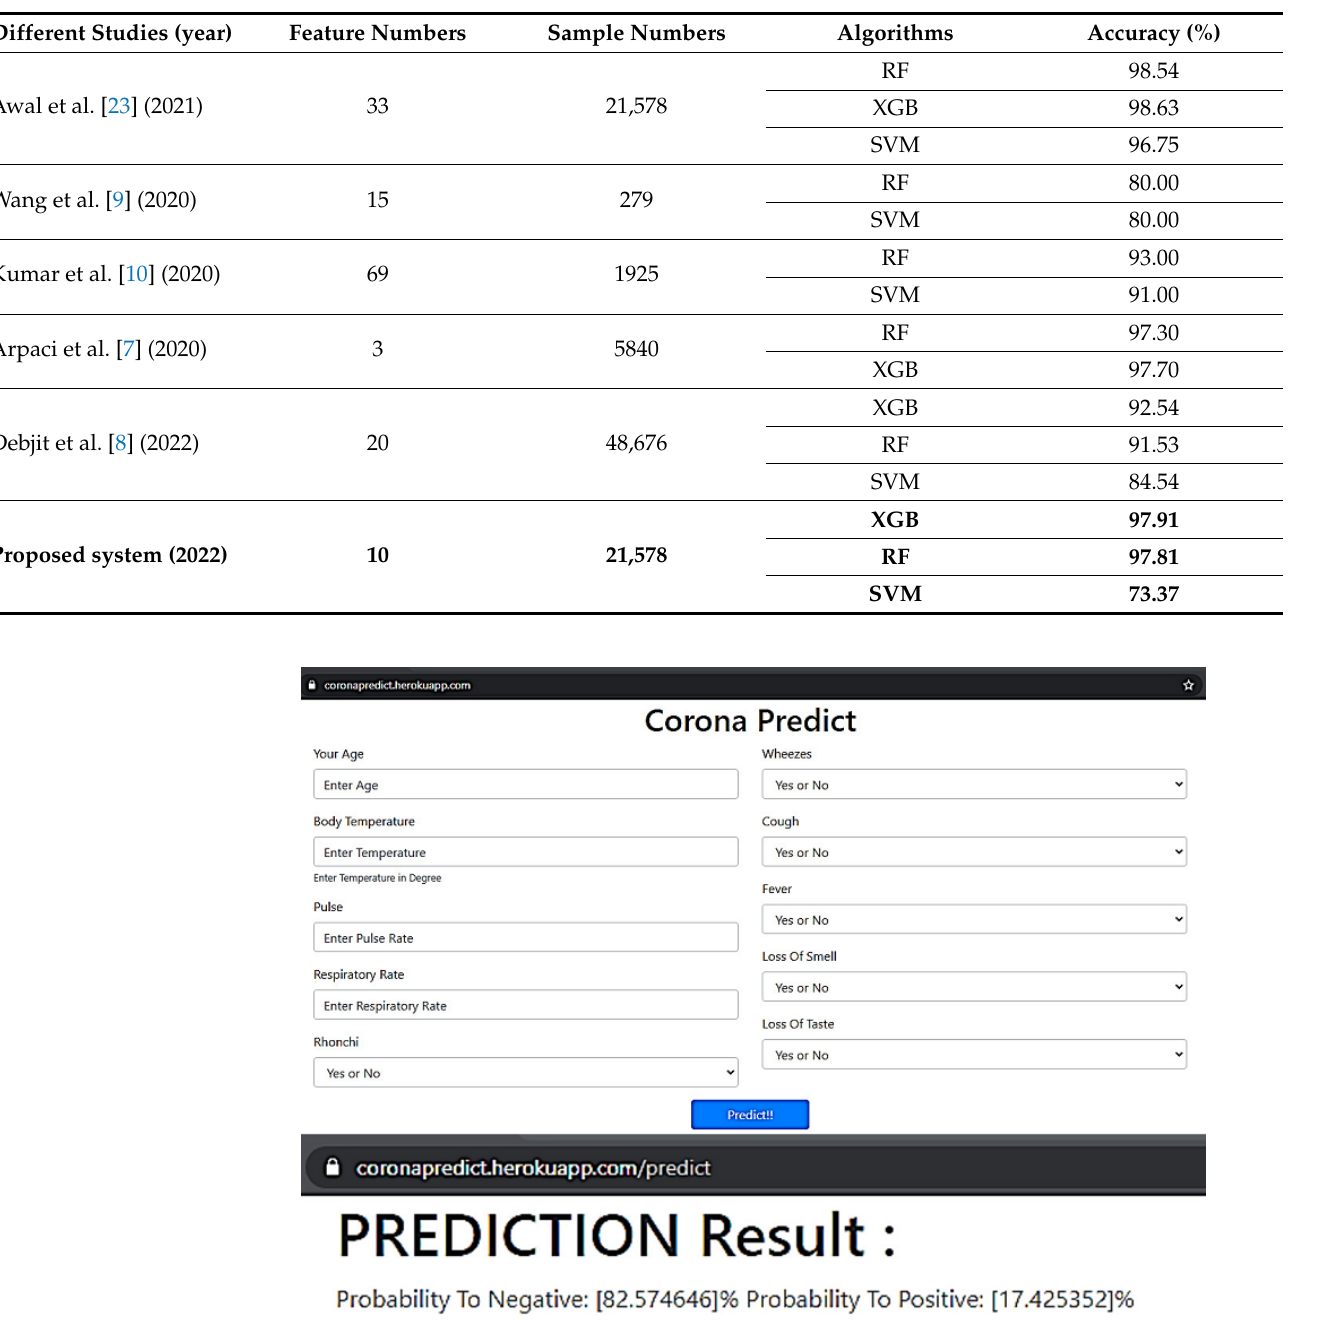
Table 7. Comparison of accuracy between the existing outcomes and the proposed system.